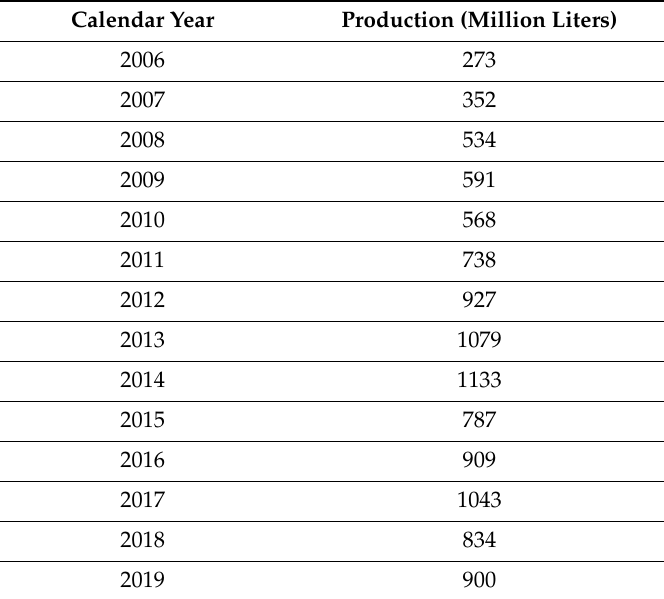
Table 5. Annual production of biodiesel in